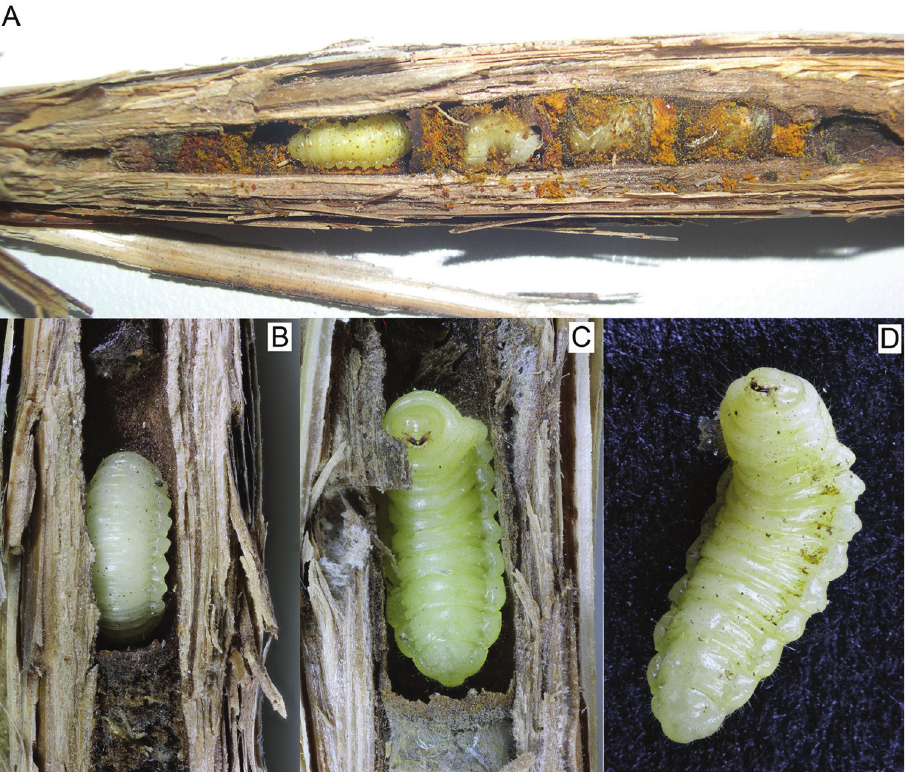
Figure 3. Nests with larvae of Gasteruption . A Larva of Gasteruption nigrescens in nest of Heriades rubicola (Hungary, Szeged, 2017) B Larva of Gasteruption nigrescens in nest of Hoplitis leucomelana (Czech Re- public, Novozámecký fish pond, 2018) C Larva of Gasteruption phragmiticola in nest of Hylaeus pectoralis (Czech Republic, Novozámecký fish pond, 2018) D larva of Gasteruption phragmiticola extracted from nest of Hylaeus pectoralis (Czech Republic, Dubno,